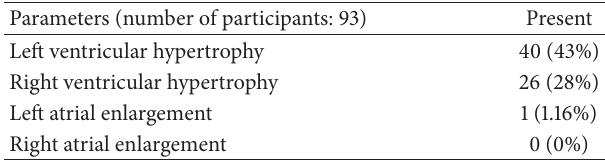
Table 5: LVH and frequency of